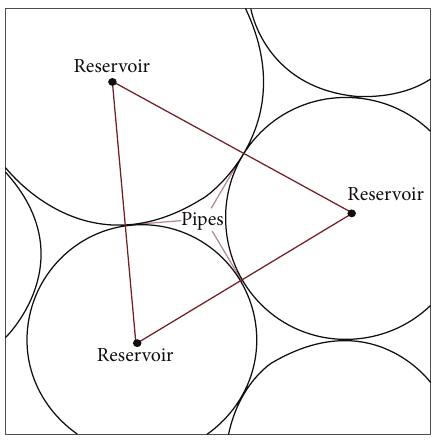
Figure 1: Heat conduction model.